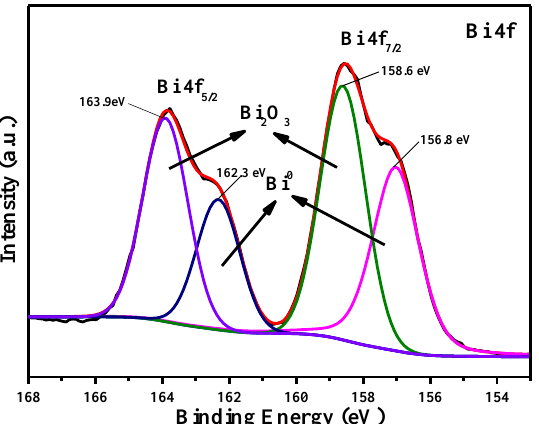
Figure 16. The XPS spectra of the electrodeposition product obtained at − 0.55 V (T = 323 K, c(BiCl 3 ) = 0.10 M).